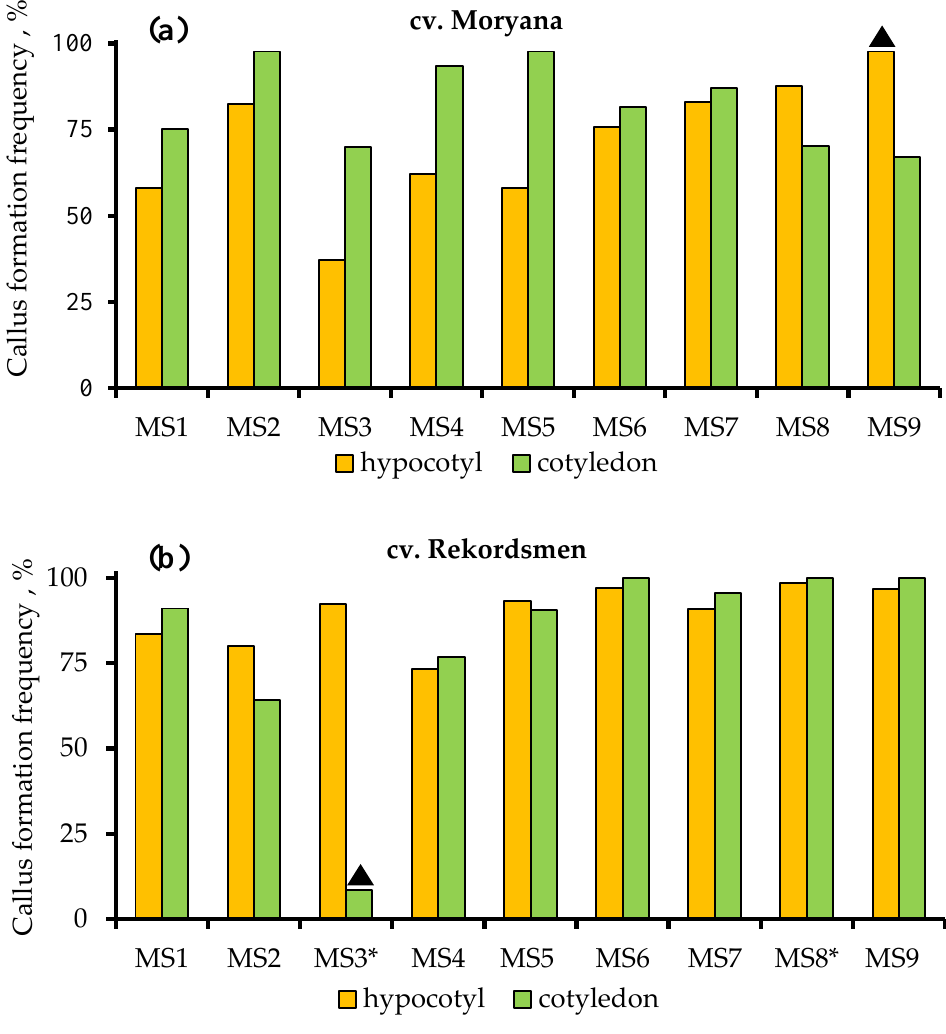
Figure 2. Influence of MS culture media supplemented with different types and concentrations of β-lactam antibiotics (MS2–MS9) on the callus formation frequency from hypocotyl and cotyledon explants of tomato cv. Moryana ( a ) and Rekordsmen ( b ). Abbreviations: ▲ —variants of culture media that have significant differences (α = 0.05) between cotyledon and hypocotyl explants; *— variants of culture media significantly different from the control treatment (MS1).